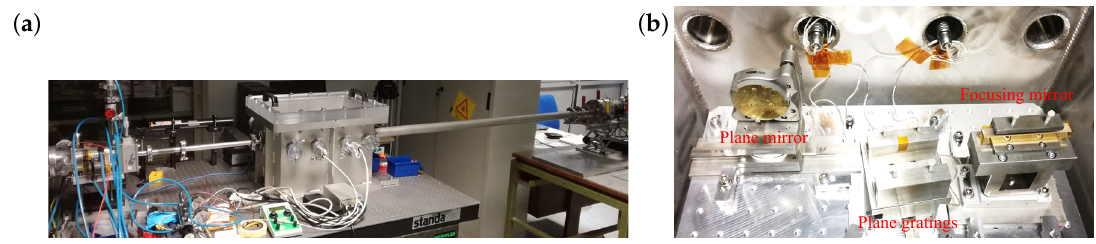
Figure 2. ( a ) External and ( b ) internal view of the three-elements monochromator vacuum